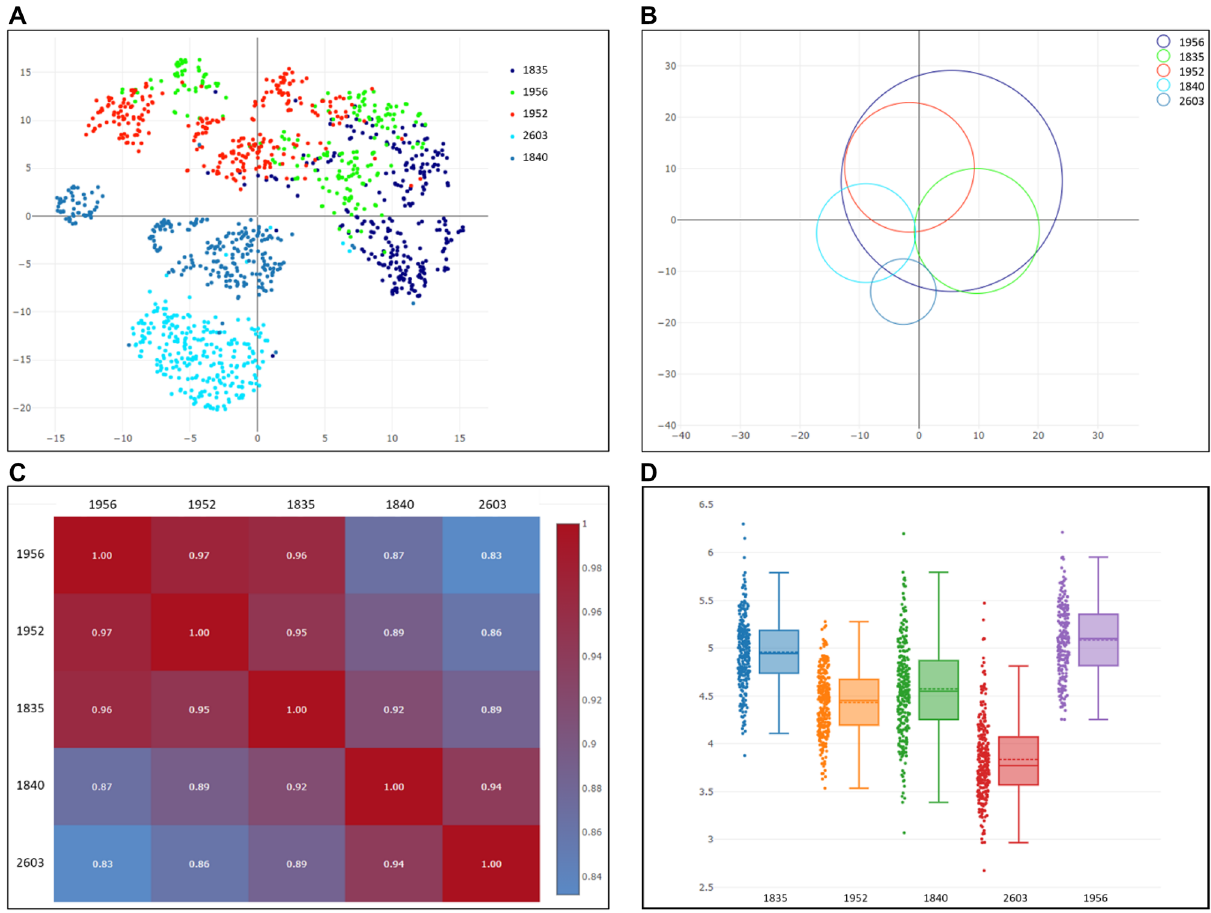
Figure 3. Morphological heterogeneity within and between five isogenic seed lots. Seed images of lots 1835, 1840, 1952, 1956 and 2603, all of variety 21, were assigned to train (90% of the data) and test (10% left-out data) a classifier to distinguish between them. Intra-lot uniformity and inter-lot similarity assigned by the classifier to the test set are conveyed by ( A ) a scatter plot, where each dot represents a given seed and lot positioning and dispersal reflects its level of uniformity and relatedness to other lots; ( B ) a bubble chart, a lot-inclusive presentation, where bubble diameter is proportional to intra-lot variance and position correlates with inter-lot similarity; ( C ) a similarity matrix, where overall similarity between the lots is denoted numerically in 0–1 scale (0 indicates no relatedness between the lots and 1—an exact match). Cell colors correlate with the numbers, according to the color bar on the right; ( D ) seed area box plot, one of numerous morphological characteristics reckoned by the classifier. ( A – C ) portray the partition of the isogenic lots into two similarity groups, one of 1840 and 2603 and another of 1835, 1952 and 1956, and the uneven lot uniformity that ranges between 2603, the most uniform lot to 1956, the least uniform one. Seed area distribution does not correlate with classifier findings that are based on multiple morphological measures. Plots were generated by Plotly.js version 2.5.1: https:// github. com/ plotly/ plotly.